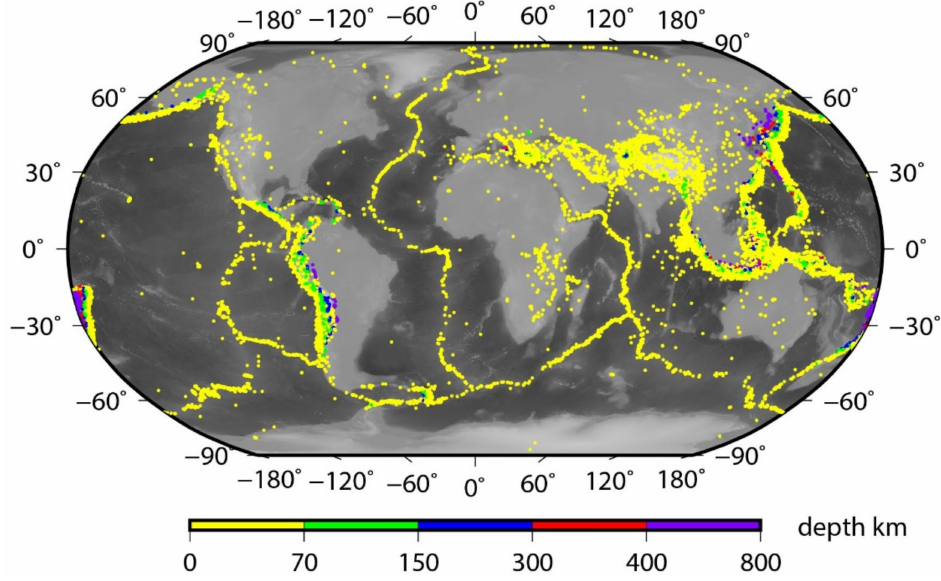
Figure 1. Distribution of IDC LEB events from 2012 to 2018, which associate MKAR phases.